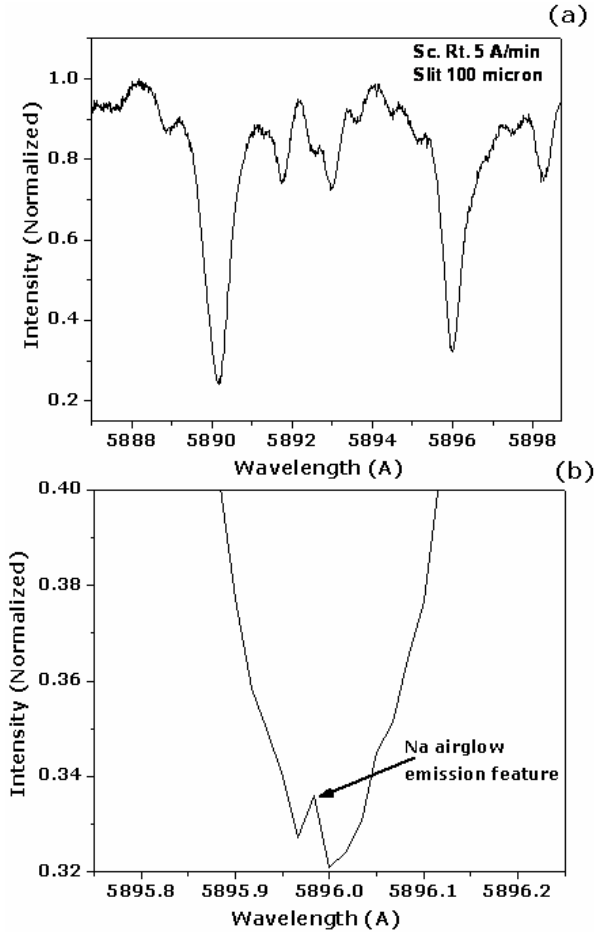
Fig. 1. (a) Solar Fraunhofer D lines (5890 and 5896 ˚A) on a clear day measured by the spectrometer using 100µm slit width and 5 ˚Amin − 1 scan speed. (b) Zoomed in Fraunhofer D1 line (5896 ˚A) which shows the Na airglow emission feature.